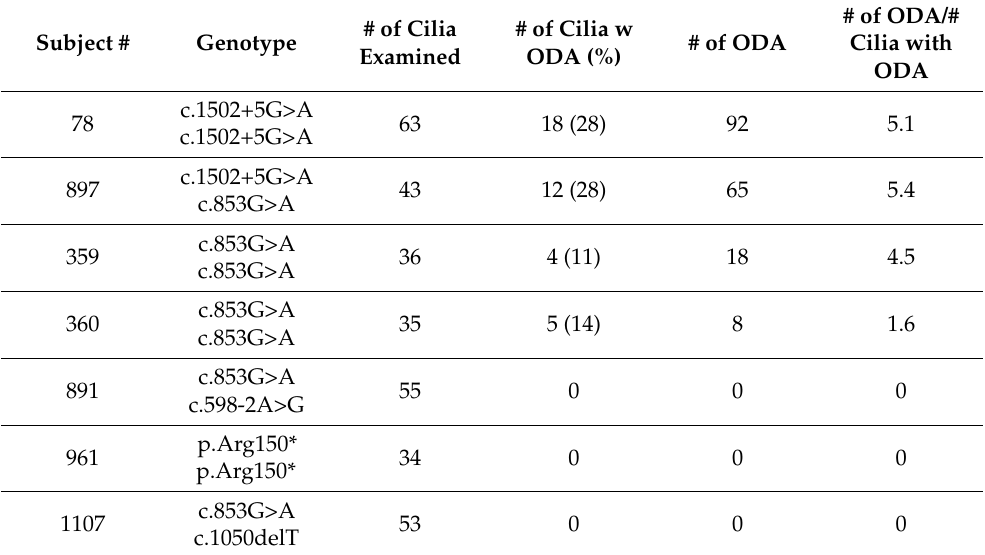
Table 2. Quantification of ODA in subjects with mutations in ODAD1